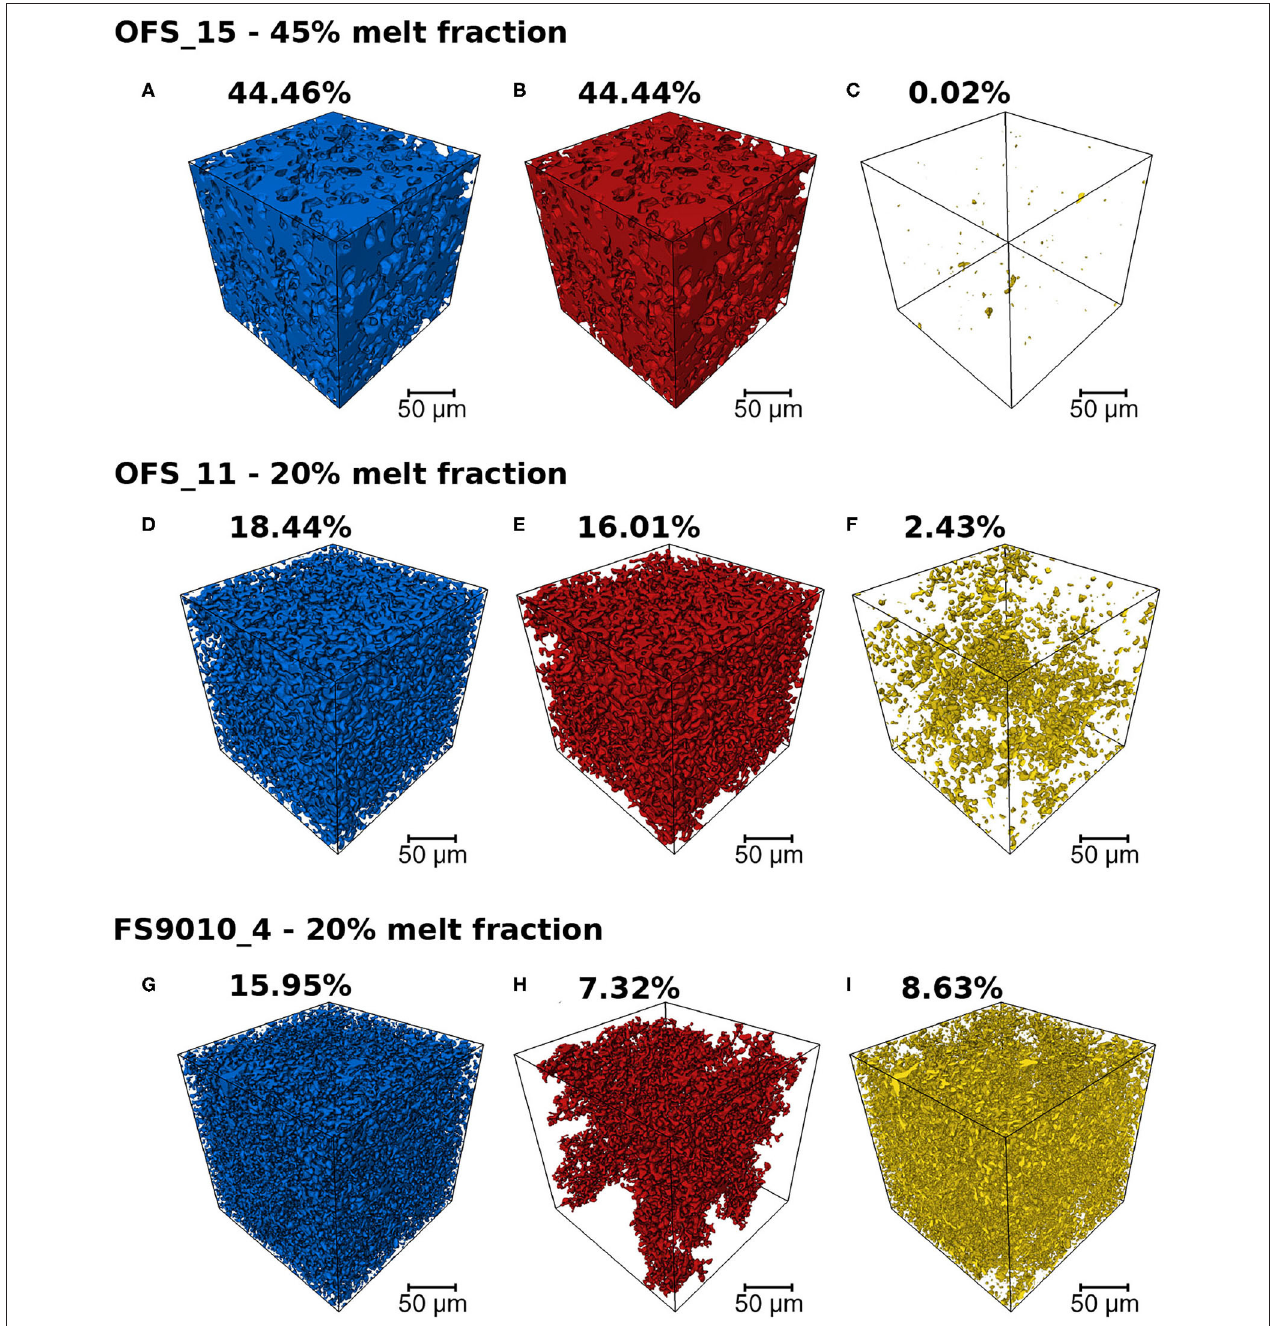
FIGURE 4 | Variation in melt fraction connectivity between samples. The top row belongs to sample OFS-15 – subvolume 1. The middle row is sample OFS-11 – subvolume 2. The bottom row is sample FS9010-4 – subvolume 1. For each sample the total melt distribution is shown in blue (A,D,G) , the connected melt distribution in red (B,E,H) , and isolated melt distribution in yellow (C,F,I) . The melt fraction listed on top of each panel is the bulk melt fraction in the sample, which can be different from the total melt fraction in each subvolume due to heterogeneous melt distribution during annealing. See the text in sections 2.3 and 4.1 for more discussions about the selection of subvolumes.